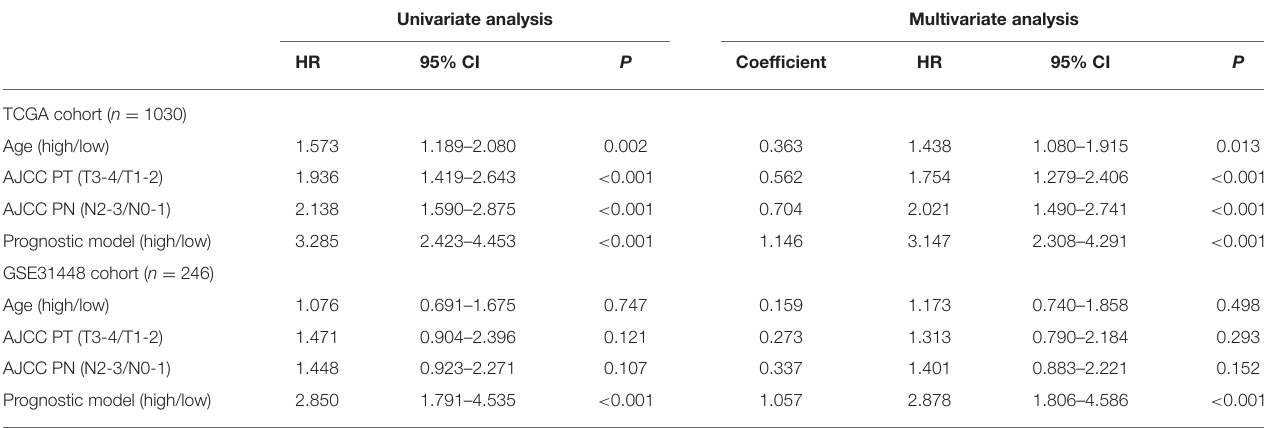
TABLE 3 | Results of Cox regression